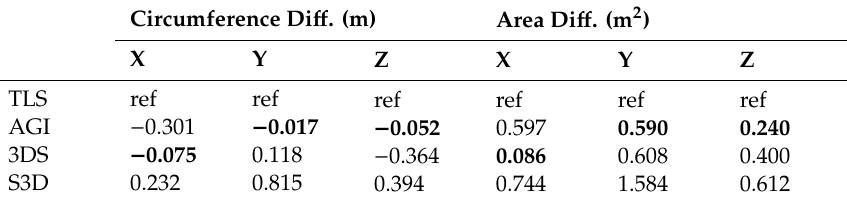
Table 5. Boulder No. 1: circumference and the section area—model differences.